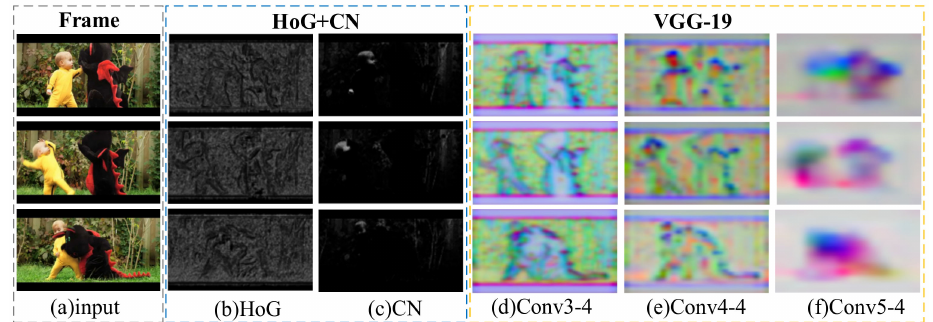
Figure 1. Visualization of multi-level features. ( a ) Three challenging frames on the DragonBaby sequence. ( b ) Histogram of oriented gradient (HoG). ( c ) Color Name. ( d – f ) are high-level features extracted from Conv3-4, Conv4-4, and Conv5-4 of